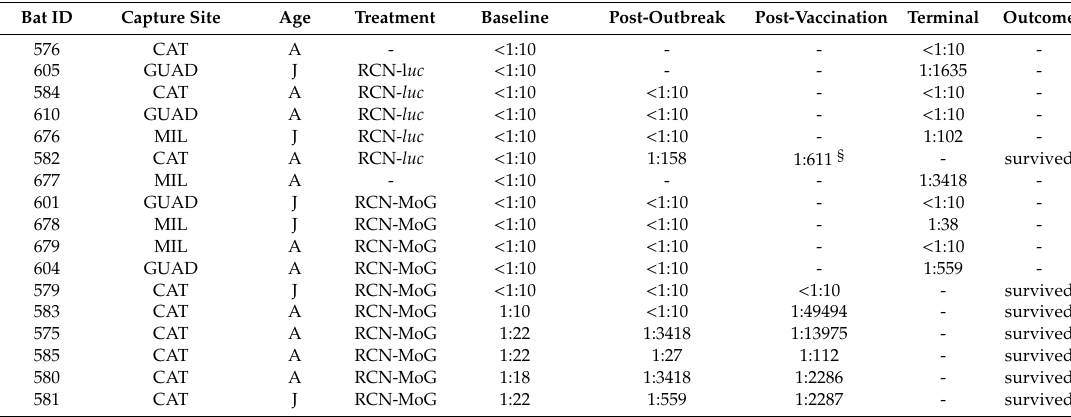
Table 2. Antibody titers of vampire bats collected from sites in M é xico (Guadalc á zar—GUAD; Catedral—CAT; Milagro—MIL) involved in natural rabies outbreak at baseline, post-outbreak (pre-vaccination; Days 119–127), post-vaccination (Day 148), and terminal for those bats that died of rabies during the outbreak. Treatments included RCN-expressing mosaic glycoprotein (RCN–MoG), a rabies vaccine candidate, and RCN-luciferase ( luc ), a placebo. Age group is indicated as A = adult, J = juvenile.